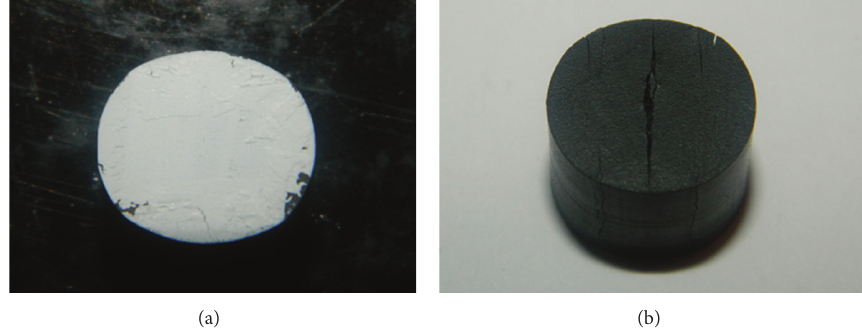
Figure 7: Posttest photographs of (a) pure vinyl ester sample elliptically deformed without diametrical splitting and (b) nanoreinforced composite sample with diametrical splitting.